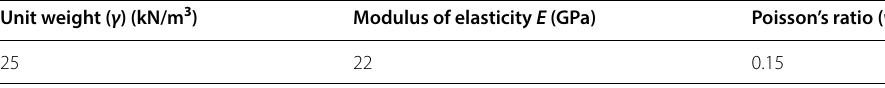
Table 1 Properties of concrete used for strip footing Unit weight ( γ ) (kN/m 3